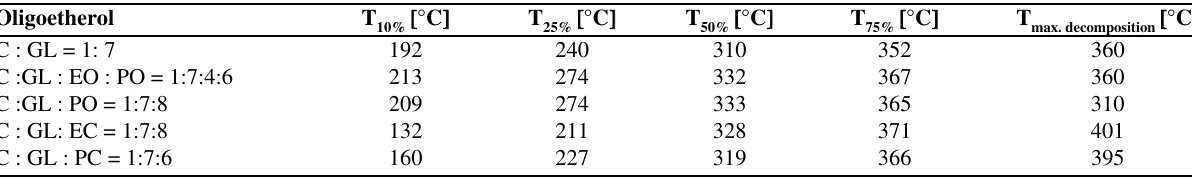
Table 6. Comparison of thermal resistance of oligoetherols Oligoetherol